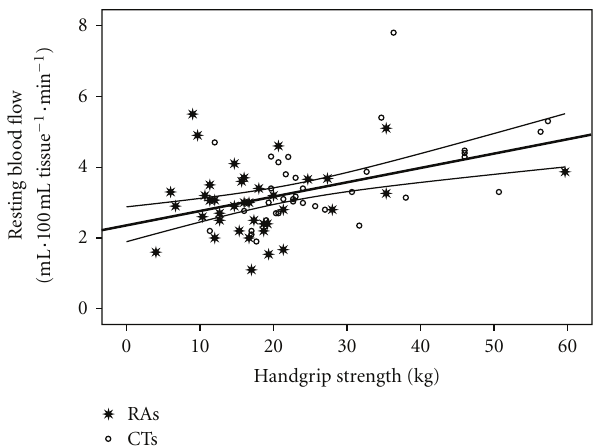
Figure 2: Relationship between handgrip strength and rest forearm blood flow. r = 0 . 43; P = 0 .